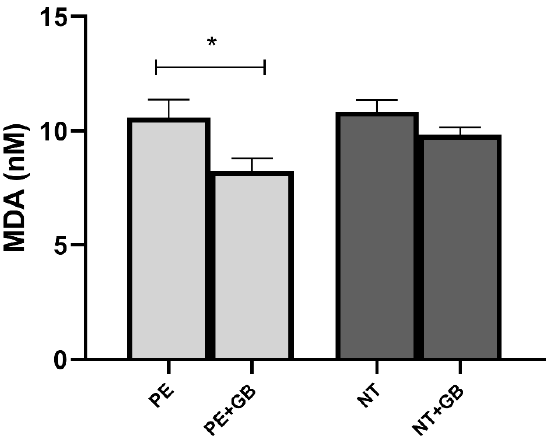
Figure 5. MDA was evaluated in the supernatant of human umbilical vein endothelial cells (HUVECs) incubated with 20% ( v / v ) pooled plasma from PE (n = 10) and NT (n = 10) and GB (100 µ M) for 24 h. Data are reported as means ± SEM. Comparisons between groups were assessed by One-Way ANOVA followed by Tukey’s Test. * ( p < 0.05).